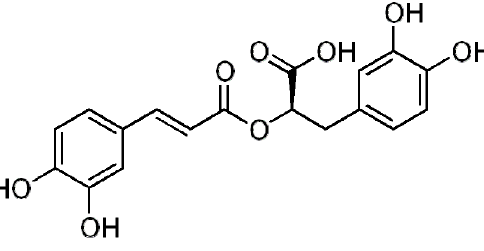
Figure 1. Structural formula of rosmarinic acid.